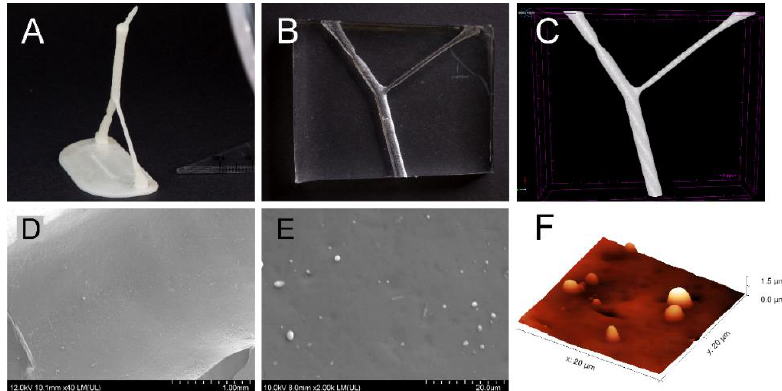
Figure 2. In vitro middle cerebral artery models prepared using 3D printing. A MCA model 3D printed using butenediol vinyl alcohol (BVOH) filament before casting into silicone ( A ), silicone MCA model prepared by dissolution of casted BVOH ( B ), 3D-rendered volume of the silicone MCA model obtained from microCT scanning showing the high quality of final MCA model without any imperfections ( C ), the surface of MCA lumen from silicone was observed using scanning electron microscopy. Only microscopic spherical-shaped imperfections of hundreds of nanometers were observed on the smooth surface of the silicone ( D ), detailed view of SEM image ( E ), AFM confirmed